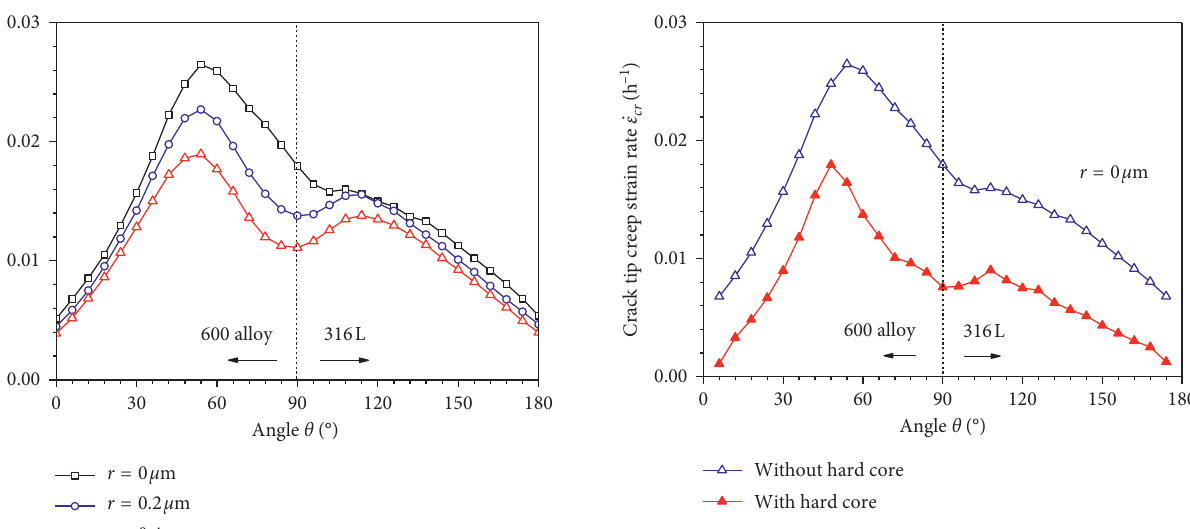
Figure 8: Comparison of the creep rate of the crack tip with and without hardening.